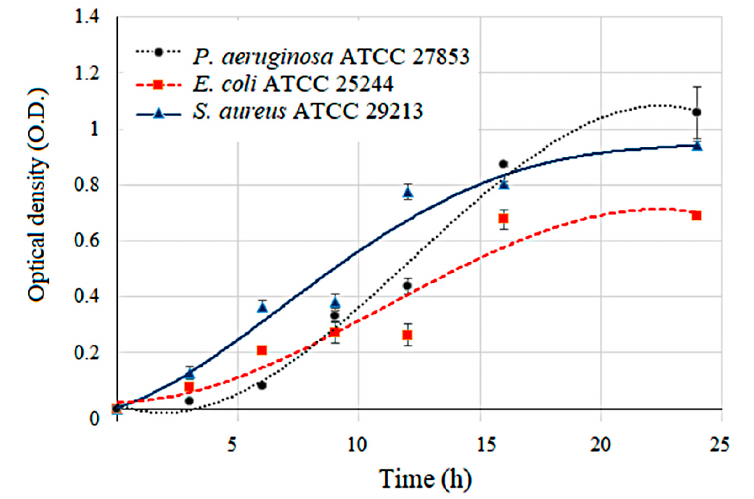
Figure 6. The optical density at 600 nm (OD600) was plotted versus time for individual pathogens in culture over an incubation period of 24 h. The growth curves were distinct for each pathogen. Blue triangle, red square, and black circle represent the data points used to construct the growth curves of S. aureus , E. coli, and P. aeruginosa , with R-squared (R 2 ) statistics of 0.9628, 0.9214 and 0.9881, respectively.